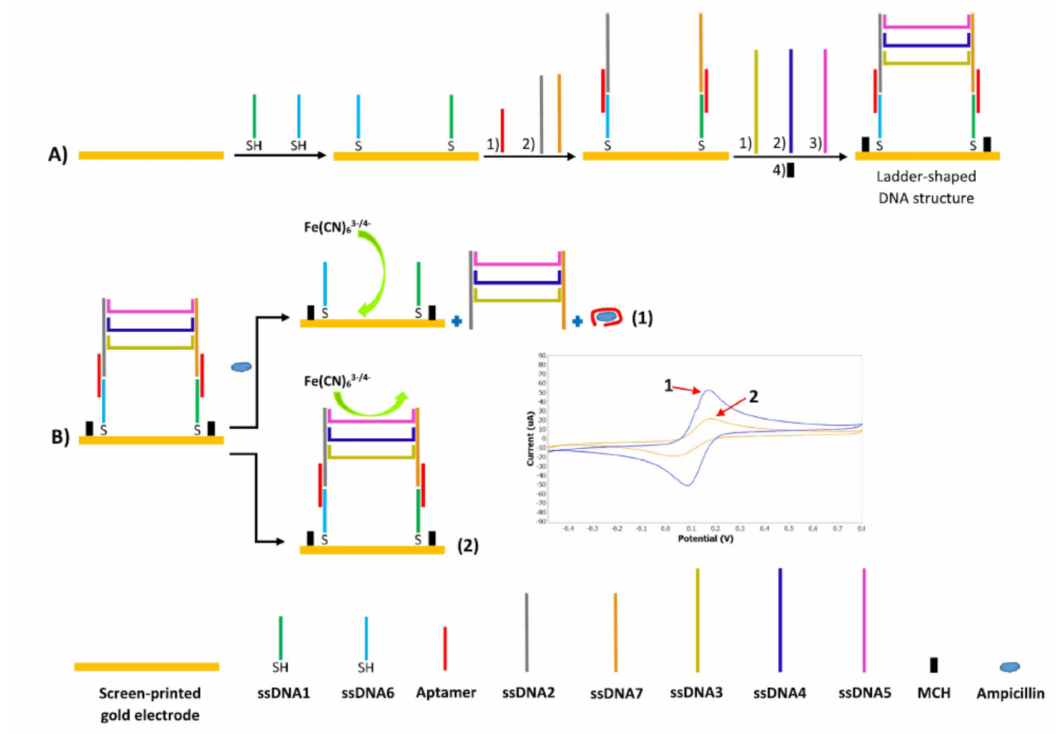
Figure 7. Schematic illustration of a label-free electrochemical aptasensor based on ladder-shaped DNA structure for the detection of ampicillin in milk. Reprinted from reference [32] with permission from Elsevier.